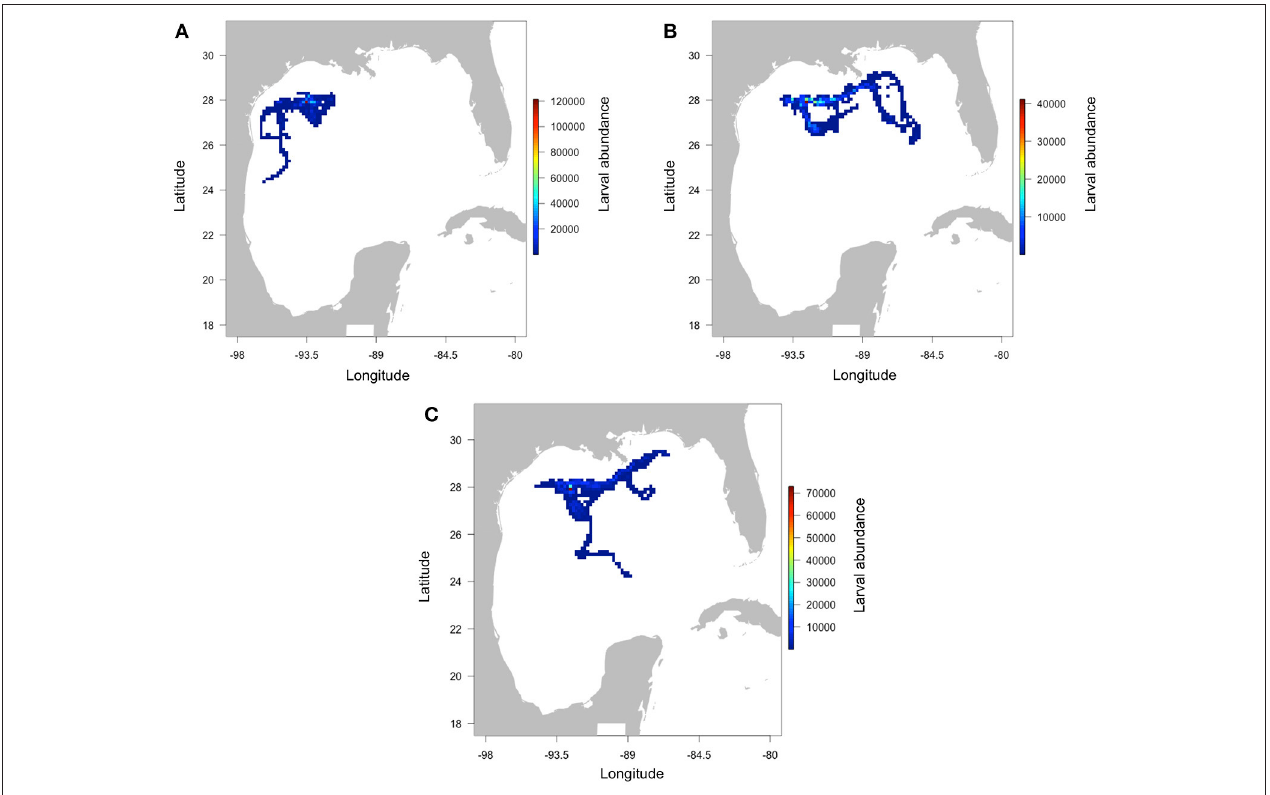
FIGURE 2 | Predicted larval abundance of M. cavernosa in the Gulf of Mexico after release from the banks (West FGB, East FGB, Bright, Geyer, Mc Grail; see Figure 1 for the location of each bank) for the years 2013 (A) , 2014 (B) , and 2015 (C) . The number of larvae was summed inside a grid cell of 0.15 × 0.15 ◦ .